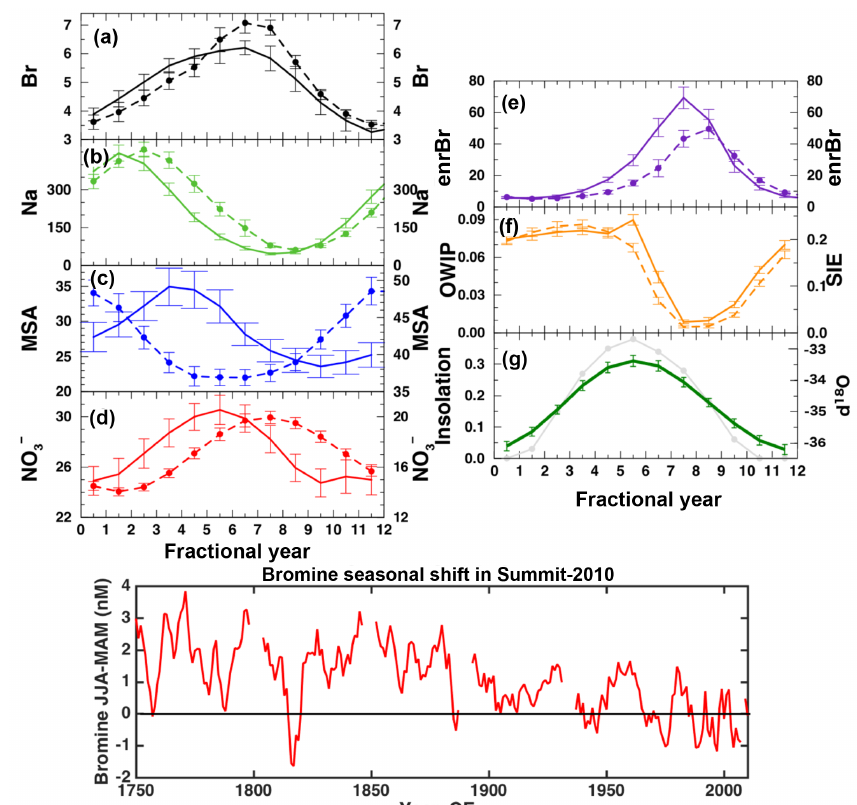
Figure 3. Upper panels: average seasonal cycle of species in the Summit-2010 ice core. The left-hand y axes are associated with the solid lines and the right-hand y axes associated with the dashed lines. Dashed lines (a – e) average seasonal cycle from depths 43.5–87.3m (years 1742–1900). Solid lines (a – e) average seasonal cycle from 0 to 43.5m (years 1900–2010). Error bars indicate the standard error of the monthly value. (a) Total bromine, (b) total sodium, (c) MSA, and (d) nitrate. Units for (a – d) are nM. Note that the seasonal cycle in bromine appears to broaden in the 1900–2010 period (see lower panel). Note also that the MSA maximum shifts from spring in the shallowest part of the ice core (solid line) to winter in the deepest part of the ice core (dashed line) due to post-depositional effects (see Fig. S1). (e) Average seasonal cycle in bromine enrichment (relative to sea salt sodium; see Eq. 3). ( f , right) The sea ice extent (SIE × 10 6 km 2 ) within an area of the East Greenland coast (70–63 ◦ N, 15–45 ◦ W). ( f , left) Area of open water within the sea ice pack (OWIP × 10 6 km 2 ) for the area defined by SIE. ( g , left) Solar insolation at 12:00GMT at the latitude of Summit (http://eosweb.larc.nasa.gov). ( g , right) Annual cycle of the δ 18 O water signal averaged over 1900–2010CE. Lower panel: broadening of bromine seasonal cycle in the Summit-2010 ice core. The difference between the summer and spring bromine signal (JJA–MAM) was monitored over the length of the entire ice core. In the pre-industrial era (pre-1850) bromine peaks in summer; realised as positive values of JJA–MAM. After 1900 there is a marked broadening of the seasonal signal towards spring and by ∼ 1970 the seasonal signal maximum is routinely shared between summer and spring realised as an averaged JJA–MAM of approximately